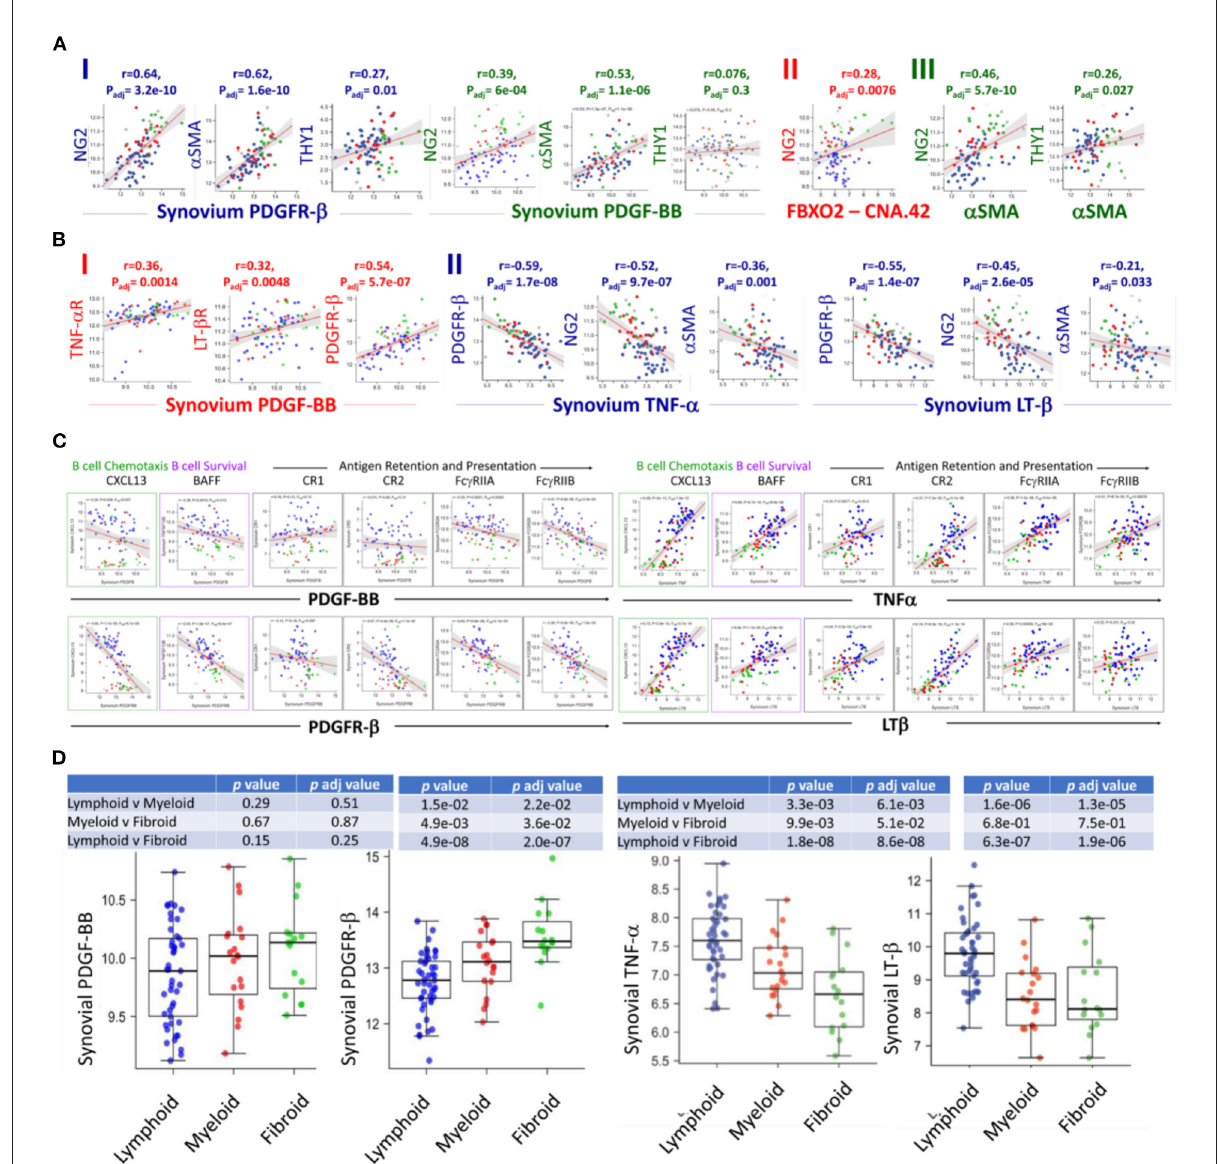
FIGURE2 RNA-Seq analysis of the PEAC cohort illustrates the differential correlation of the FDC genes associated with early perivascular and late mature developmental stages in the RA synovium. Strong positive correlations of the pericyte/fibroblast markers NG2, THY1 and α SMA with the PDGFR- β /PDGF-BB axis (A-I) , NG2 and FDC-CNA.42/FBXO2 (A-II) , and NG2, THY1 and α SMA (A-III) in RA. (B) Correlations of PDGF-BB and TNF α /LT β with the expression of each other’s receptors and early FDC developmental genes. PDGF-BB positively correlates with its receptor and the TNF α /LT β receptors (B-I) , TNF α and LT β negatively correlate with PDGFR- β expression and the early FDC markers NG2 and α SMA (B-II) . (C) Converse correlations of the PDGF-BB/PDGFR- β and the TNF- α /LT- β axes with the expression of mature FDC markers. PDGF-BB/PDGFR- β and TNF- α /LT- β differently correlate with the mature FDC related genes CXCL13 (B cell chemoattractant), BAFF (B cell survival factor), and antigen display and presentation to B cells namely complement receptors (CR1/CD35, CR2/CD21), and Fcg receptors (Fc γ RIIA/CD32A, Fc γ RIIB/CD32A). (D) Correlation of the RA synovial pathotypes with the expression of PDGF-BB, PDGFR- β , TNF- α , and LT- β . Person correlation coefficient (r) and adjusted p -values are shown with the corresponding plots and tables.